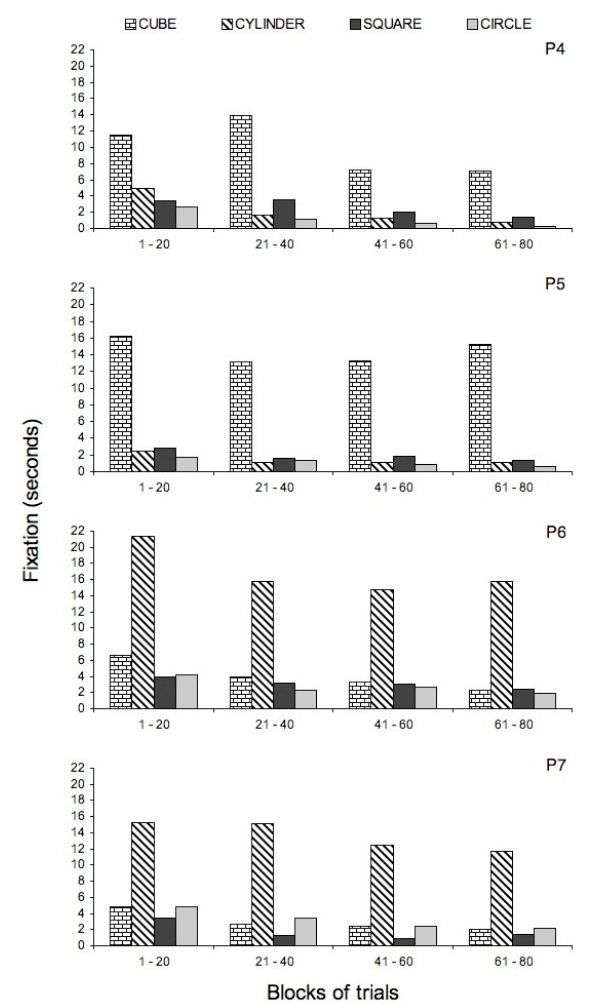
Figure 3. Total fixation time (in seconds) for each figure, per block of 20 trials, for each participant. Trials with the same configuration that followed “incorrect” choices (correction trials) are not